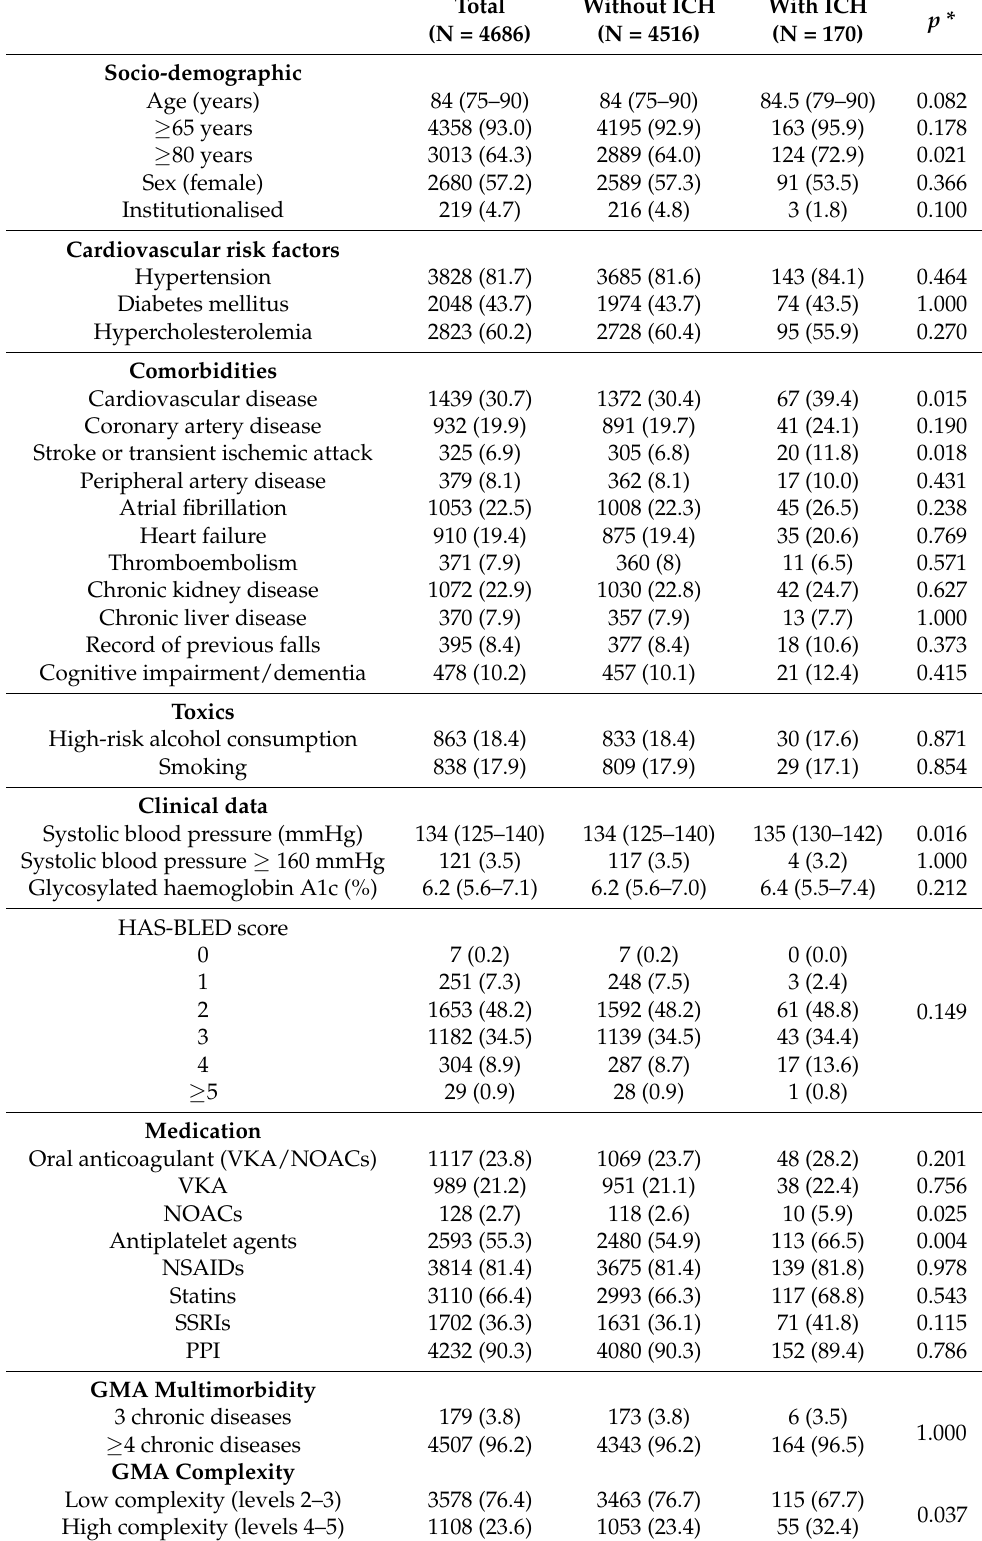
Table 1. Baseline characteristics of GMA-4 population according to ICH occurrence during